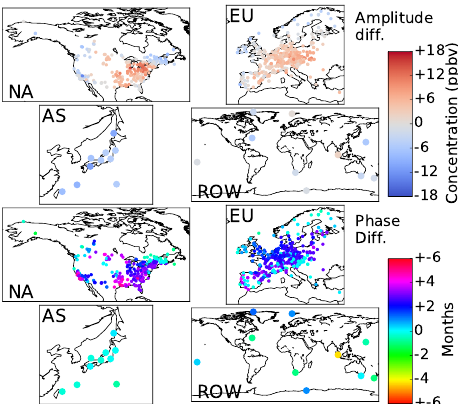
Figure 12. Diurnal amplitude (upper panel) and phase (lower panel) differences between observations and the GEOS-Chem model. NA is North America, EU is Europe, AS is Asia, and ROW is rest of world.